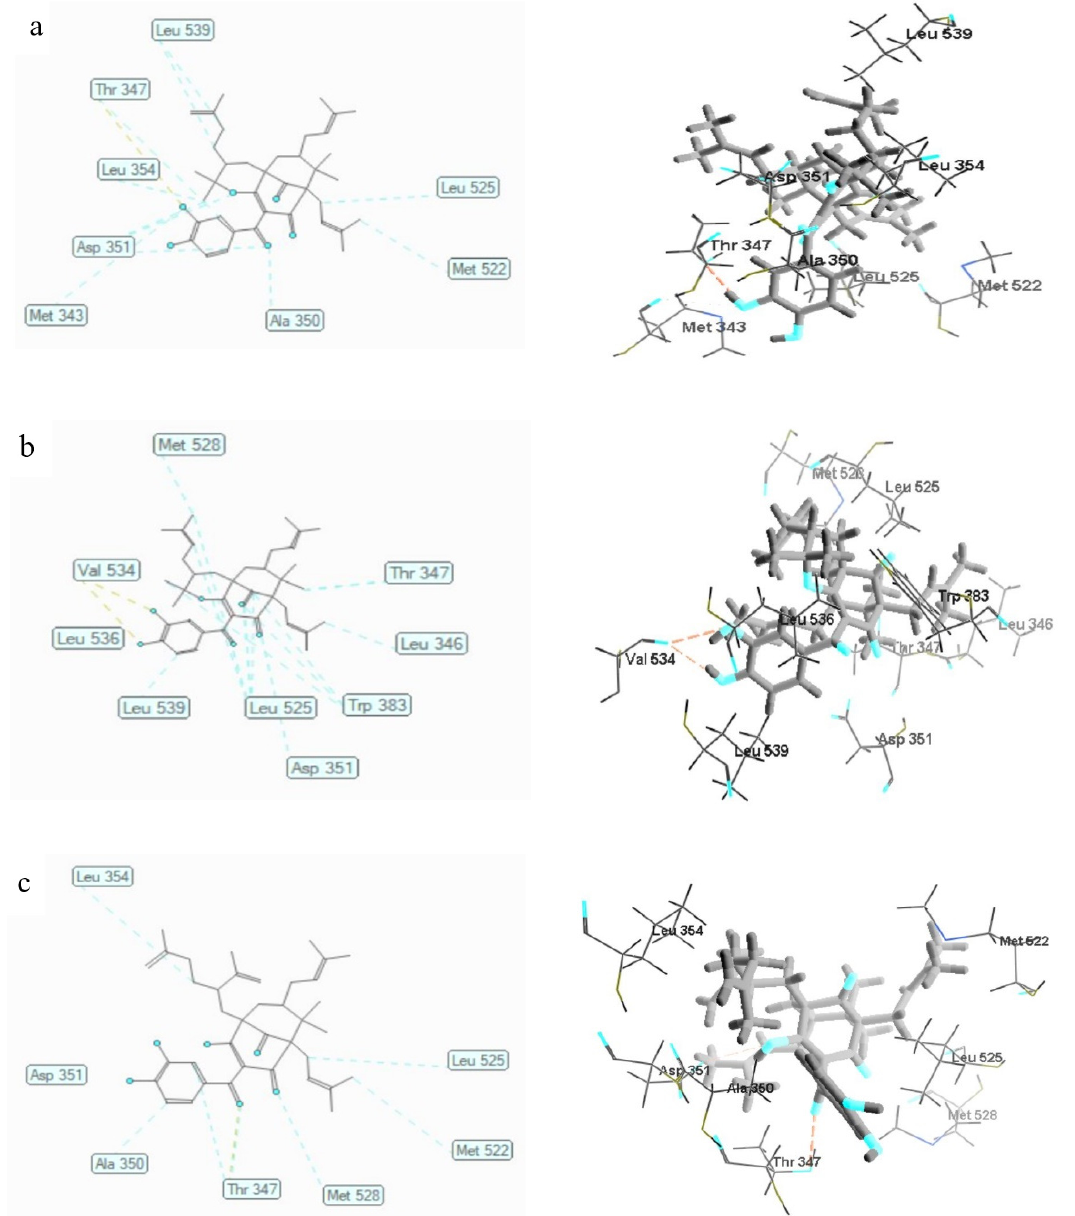
Figure 3. The 2D and 3D interaction of 1 ( a ), 2 ( b ), and 3 ( c ) with human alpha-estrogen receptor (3ERT). Hydrogen bonds are shown as yellow dotted lines while steric interactions are depicted as blue dotted lines. Carbon atoms are represented in gray, oxygen in blue, and hydrogen in black.